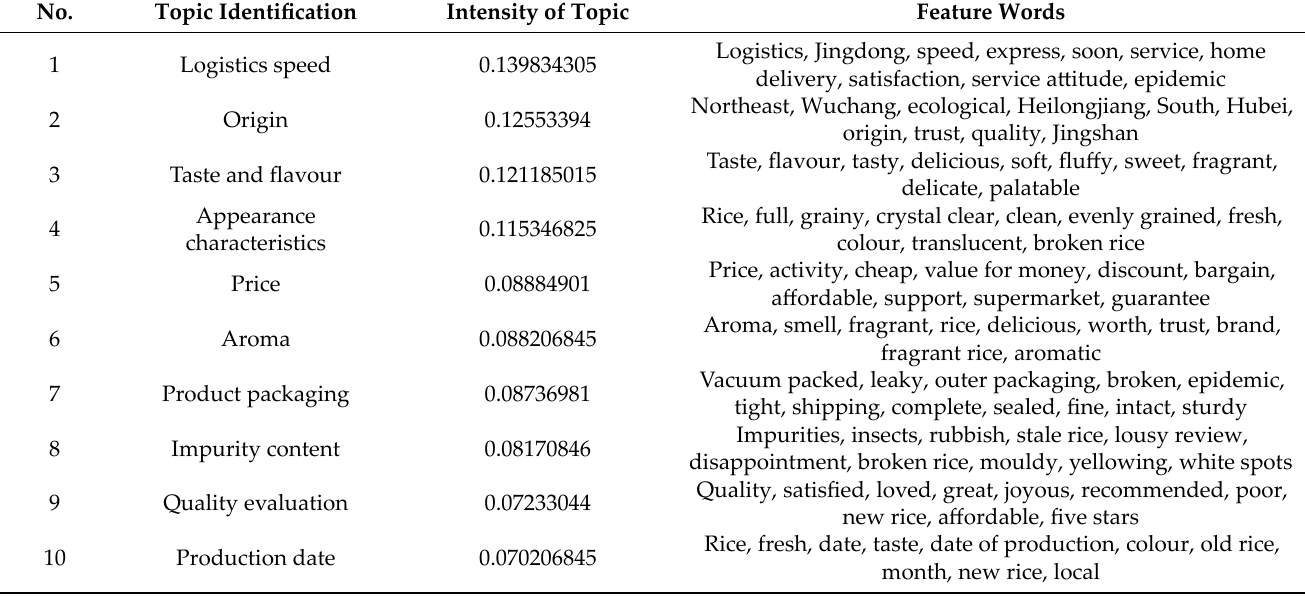
Table 3. Topic Identification and Sorting of Intensity.